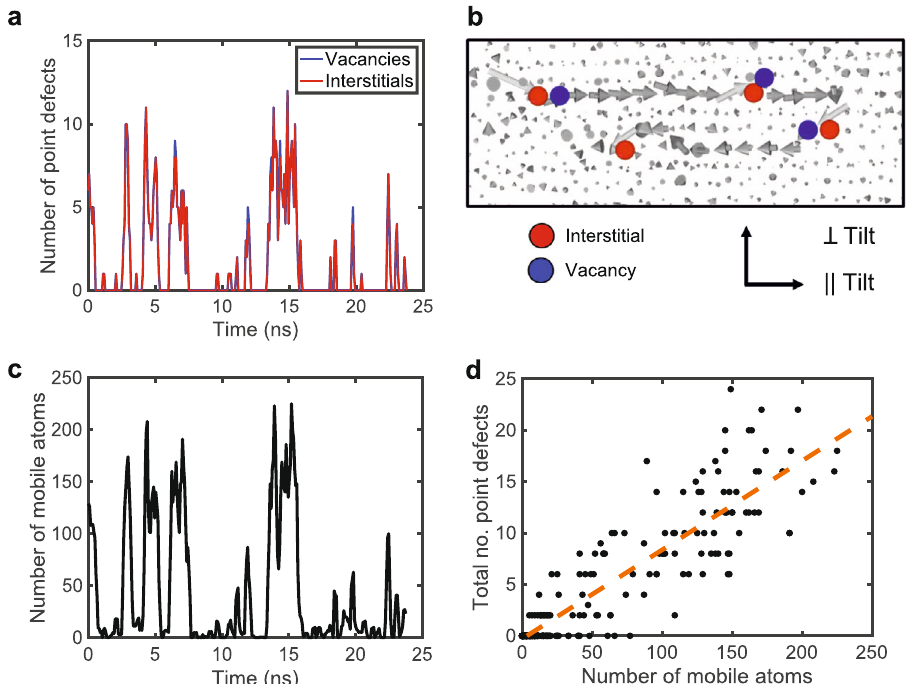
Fig. 3 Point defect signatures of avalanche-like diffusion. a Peaks in the numbers of vacancies and interstitials correlate with the locked and avalanche time periods seen in Fig. 2a. b A typical collective diffusion event involves the formation and multiplication of Frenkel pairs. The arrows represent string-like displacements during the time interval Δ t = 80 ps and colored in dark grey and light grey for displacements smaller and larger than the fi rst-neighbor distance r 0 . c Peaks in the number of mobile atoms also correlate with the locked and avalanche time periods. d Correlation between the point-defect population and the number of mobile atoms in the GB core with the correlation factor of R 2 = 0.83.